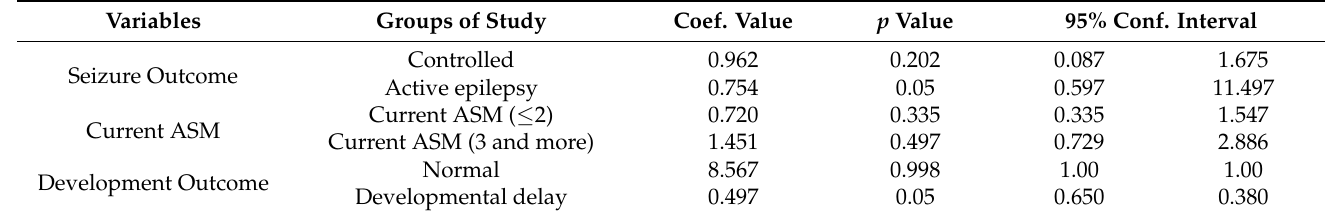
Table 3. Seizure outcome, current AS and developmental outcome in relation to outcome and 2nd MRI brain follow up. Odds ratios in the detailed regression tables (logistic regression) between the 2nd abnormal MRI with the listed